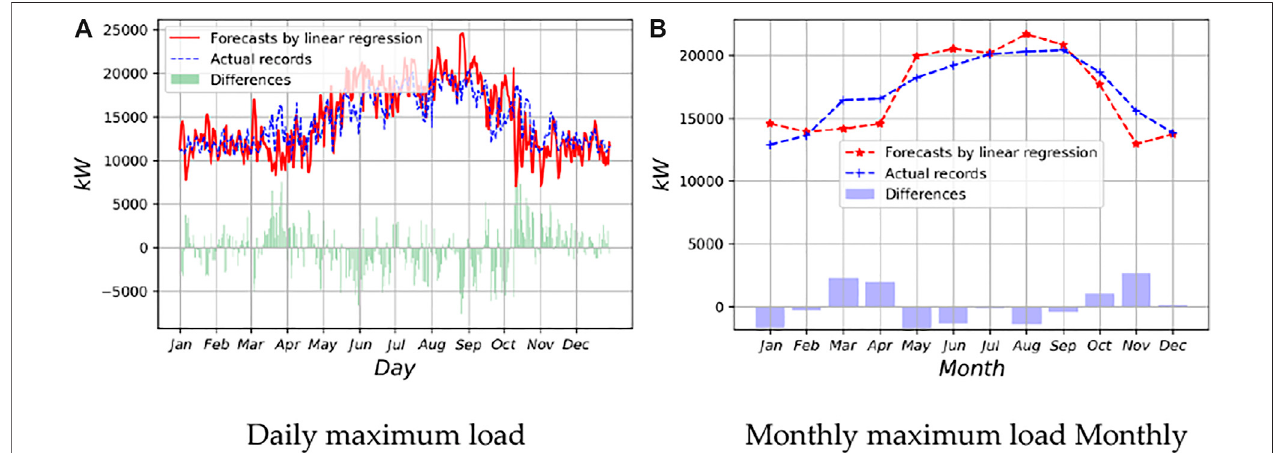
FIGURE 11 | Comparison of daily and monthly maximum load with and without COVID-19. (A) Daily maximum load; (B) Monthly maximum load Monthly.